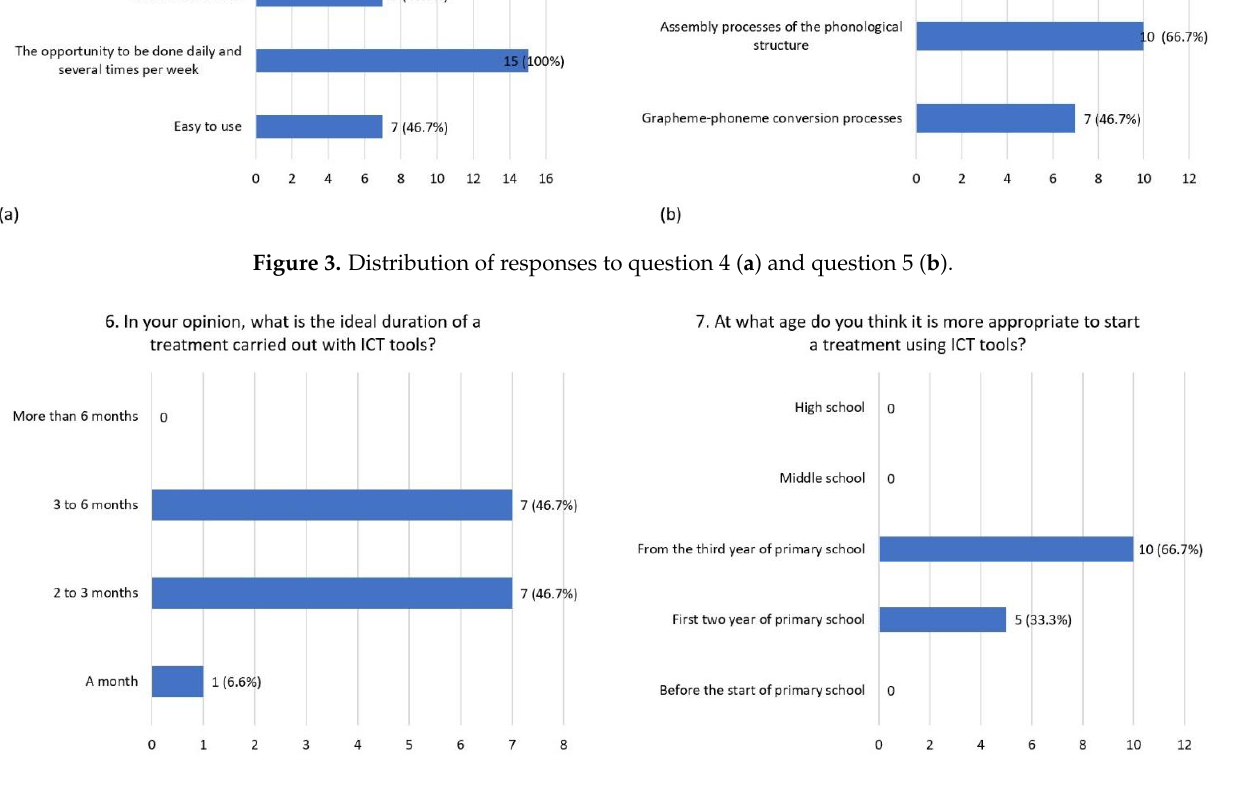
Figure 3. Distribution of responses to question 4 ( a ) and question 5 ( b ).